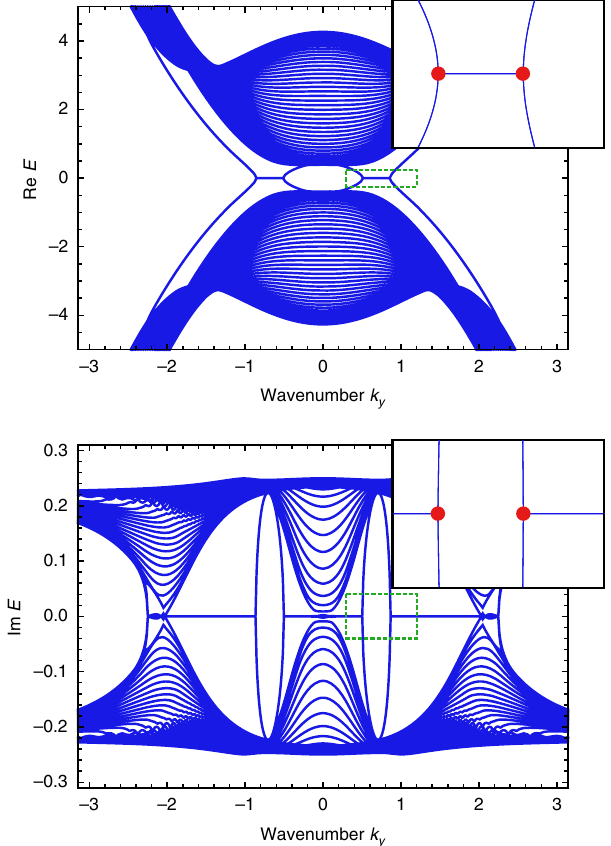
Fig. 6 Exceptional edge modes in the continuum model. The model is constructed from the continuum system with the Chern number 2 and its time reversal combined by a non-Hermitian coupling. We discretize the space and the equation, and numerically calculate the band structure under the open boundary condition in the x direction and the periodic boundary condition in the y direction. Although the model has topologically trivial bulk, it exhibits four edge bands per edge (doubly degenerated) protected by the exceptional points around Re E ¼ 0 (indicated by the red points in the inset). The parameter used here are M = 0.5, β = 0.5, a = 1, b = 0.3, and b 0 ¼ 0 :